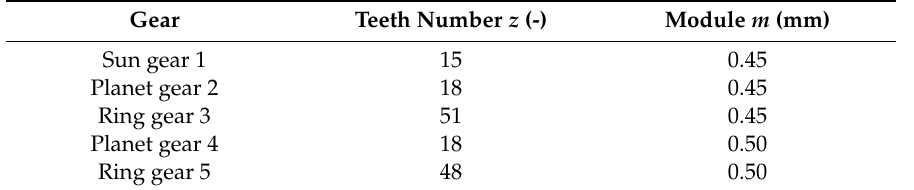
Table 1. Teeth numbers and moduli of the Wolfrom stage gears.